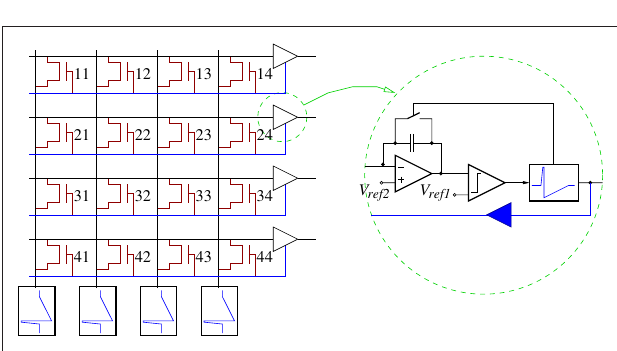
Figure 18 | Simulated memristive FeT crossbar structure and neuron detail.